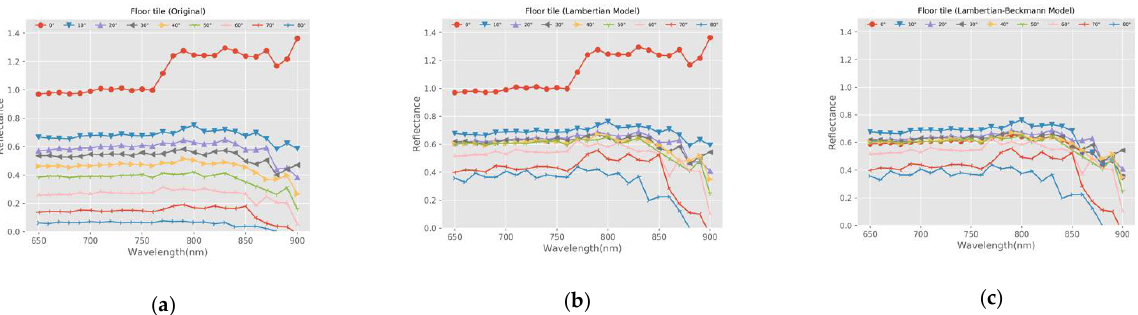
Figure 10. The reflectance comparison of Floor tile. ( a ) Before calibration; ( b ) Calibration results of Lambertian model; ( c ) Calibration results of Lambertian–Beckmann model.